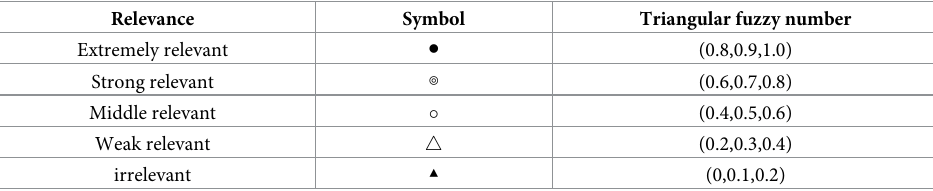
Table 4. Triangular fuzzy number of fuzzy